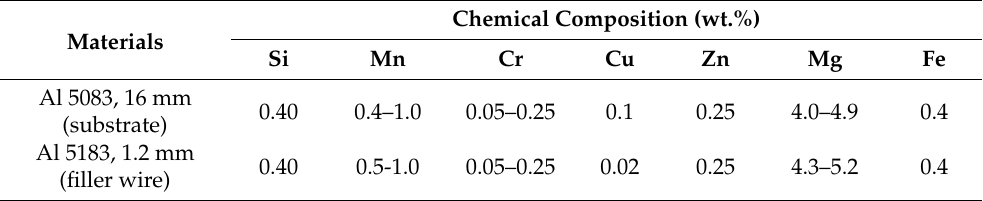
Table 2. Welding conditions and levels applied in the welding stage of the VP-GMAW process.